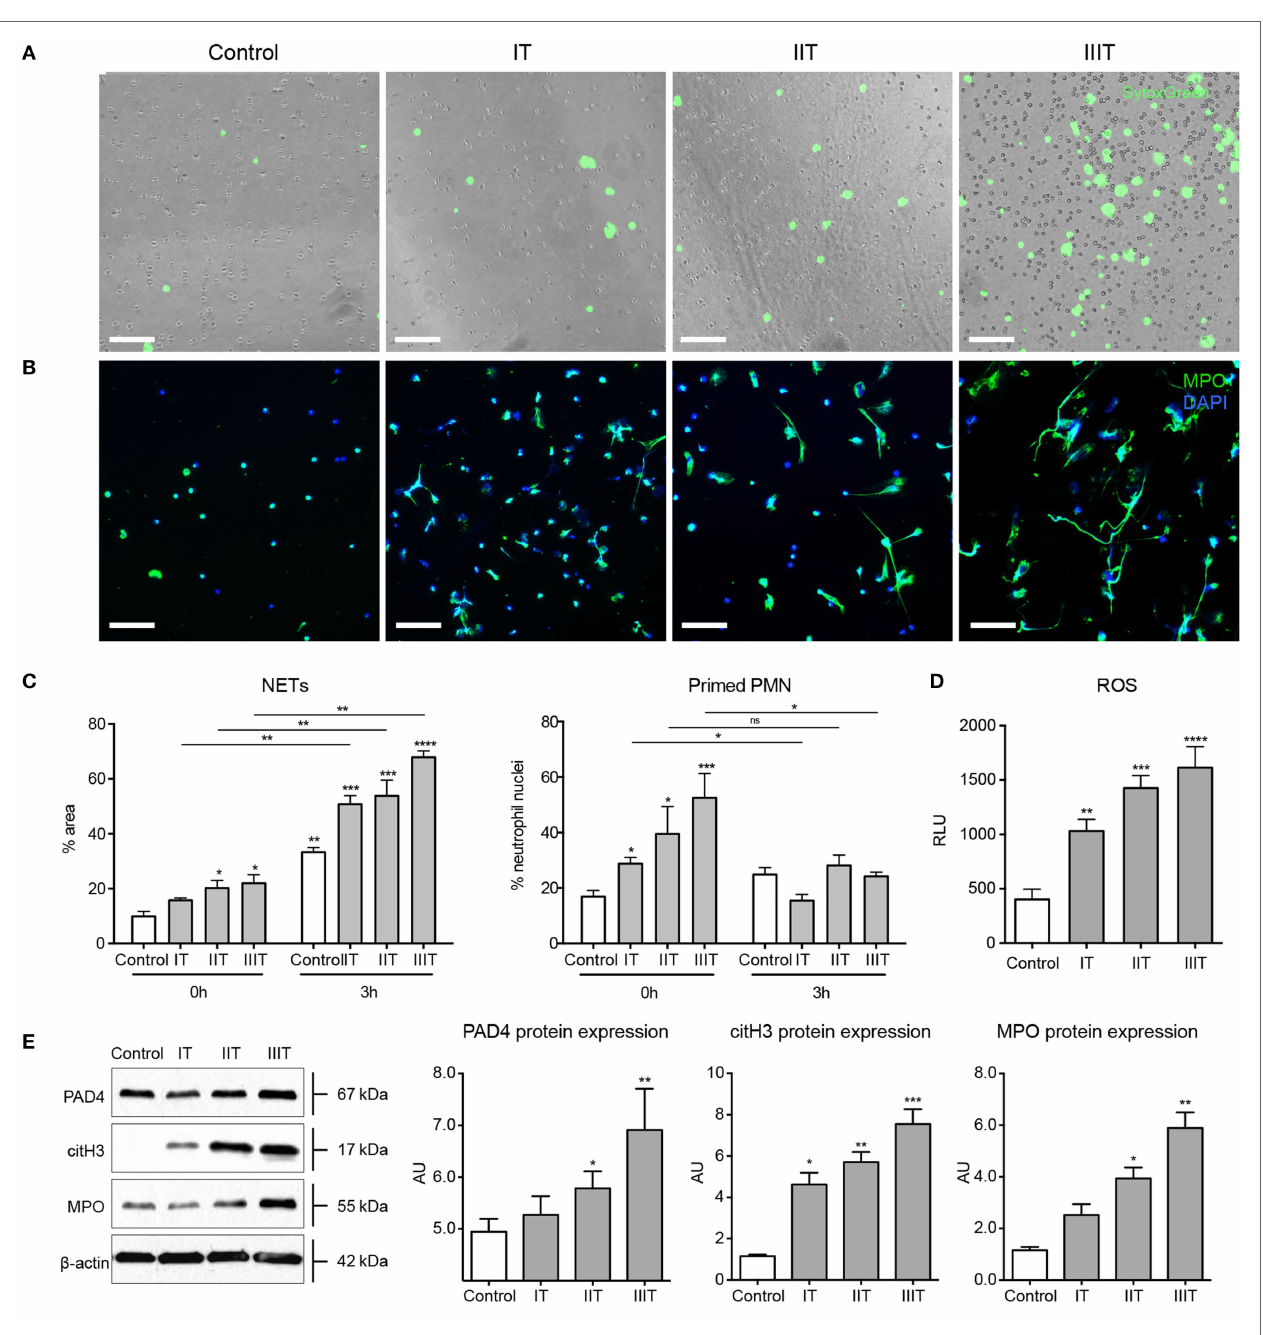
FigUre 1 | neT formation and neutrophil pro-neTotic priming are augmented during pregnancy